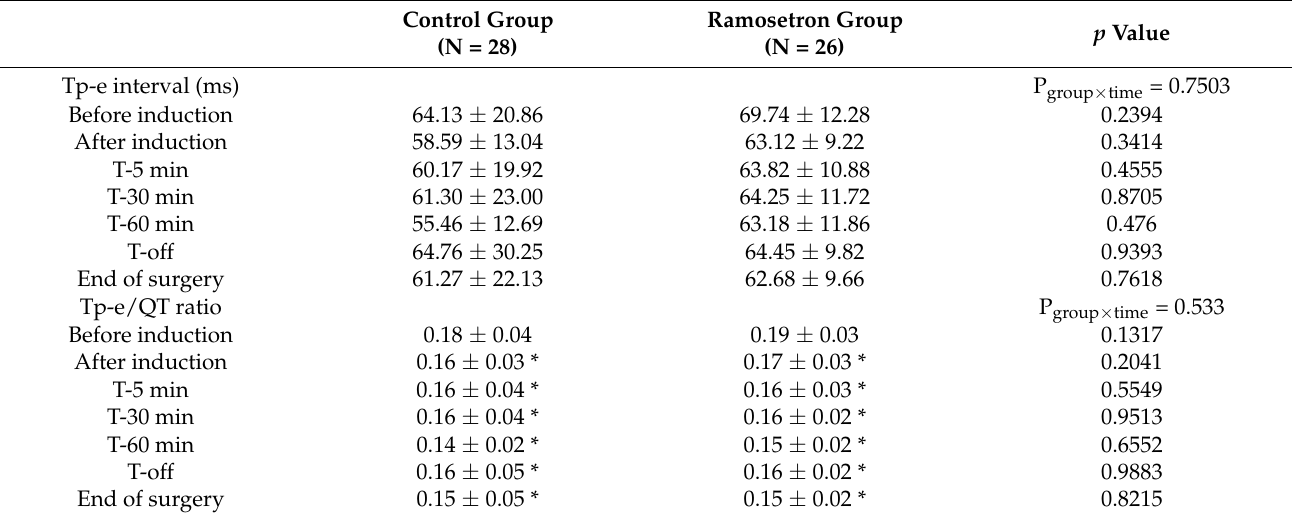
Table 4. Changes in Tpeak-Tend (Tp-e) interval and Tp-e/QT ratio during robot-assisted laparoscopic